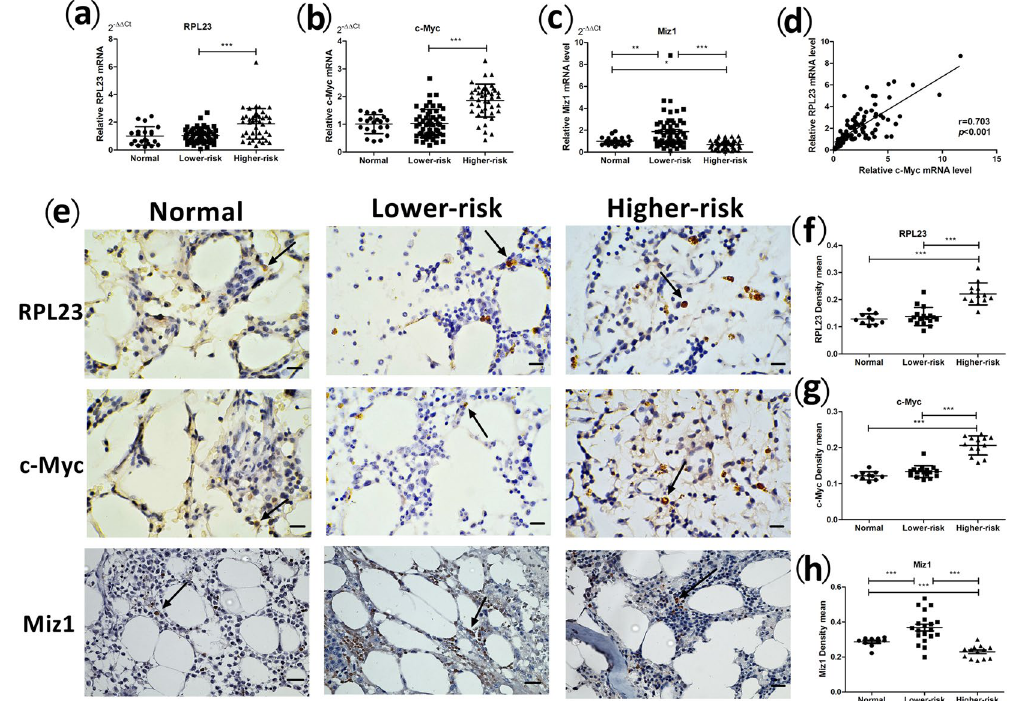
Figure 5. RPL23, c-Myc and Miz1 mRNA and protein expression levels in the BM haematopoietic cells of MDS patients. ( a ) RPL23, ( b ) c-Myc and ( c ) Miz-1 mRNA expression levels in lower-risk (IPSS scores ≤ 1.0) and higher-risk (IPSS scores > 1.0) MDS patients compared with healthy donors. Total RNA was extracted from 2 ml of BM mononuclear cells (BMNCs) from MDS patients with different risk levels using the TRIzol ® reagent. The protocols used for cDNA synthesis and qRT-PCR are described in Methods. ( d ) Correlation between RPL23 and c-Myc mRNA levels in BMNC cells from MDS patients. Pearson’s correlation test for RPL23 vs. c-Myc: r = 0.703, p < 0.000. ( e ) Immunohistochemical staining for RPL23, c-Myc and Miz-1 in BM trephine tissue of lower/higher-risk MDS patients and healthy donors. RPL23, c-Myc and Miz-1 expression is indicated by yellowish-brown cytoplasmic staining. Original magnification: 400 × . Clearly positively stained cells are indicated with arrows (scale bar: 2 μ m). The mean densities of the positive sections were calculated for measuring in vivo protein expression and are displayed in scatter plots in panels ( f ), ( g ) and ( h ). Unpaired Student’s t tests were used to calculate all p values shown throughout the figure. The data are expressed as the means ± S.E.M. * p < 0.05; ** p < 0.01; *** p <